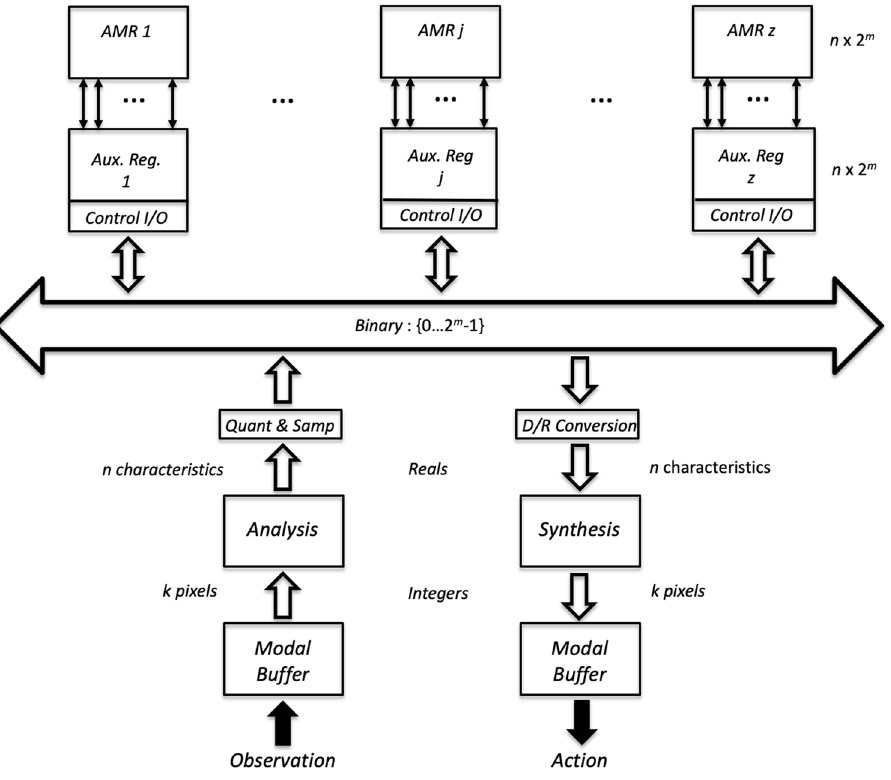
Figure 1. Associative memory